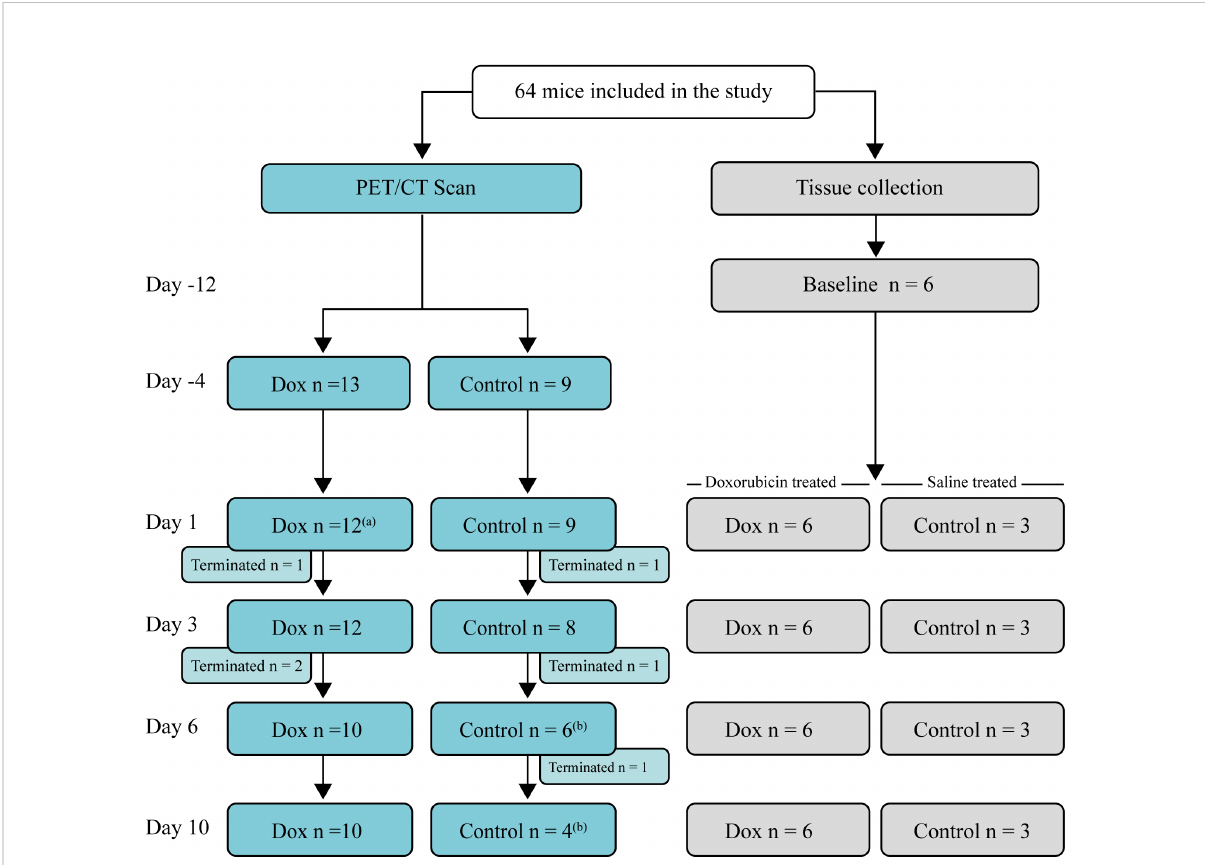
FIGURE 1 Study fl owchart and timeline. Days of data collection (either 2-[ 18 F]FDG PET/CT scans or collection of specimens for analysis) relative to the day of doxorubicin or saline injection (day 0). Left: Mice were scanned sequentially, and after each scan, a few mice (n = 1-2) were terminated for tissue collection. Right: Mice used for tissue collection. The number of mice, terminated at each time point is indicated. Mice in the tissue collection group underwent the same procedures as the mice that were scanned, except for the scan. ( a ) One mouse was erroneously not scanned. ( b ) A mouse died in relation to the 2-[ 18 F]FDG